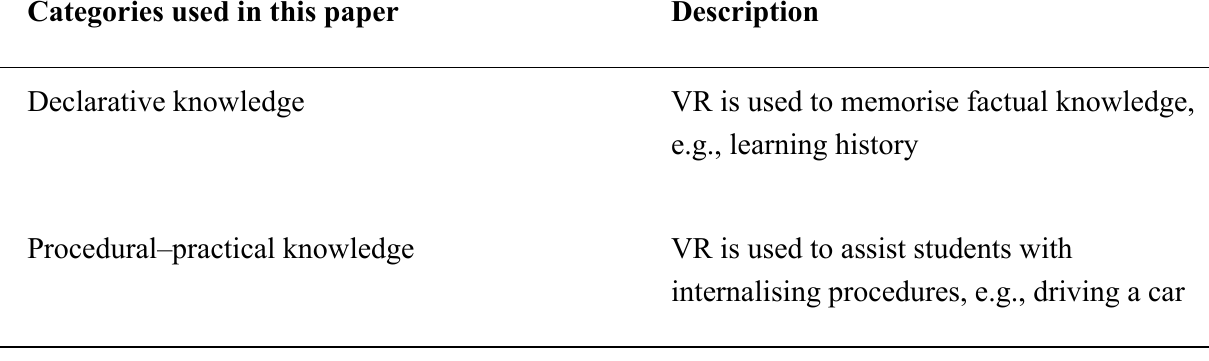
Modified Framework of Learning Goals (originally presented in Radianti et al., 2020) Categories used in this